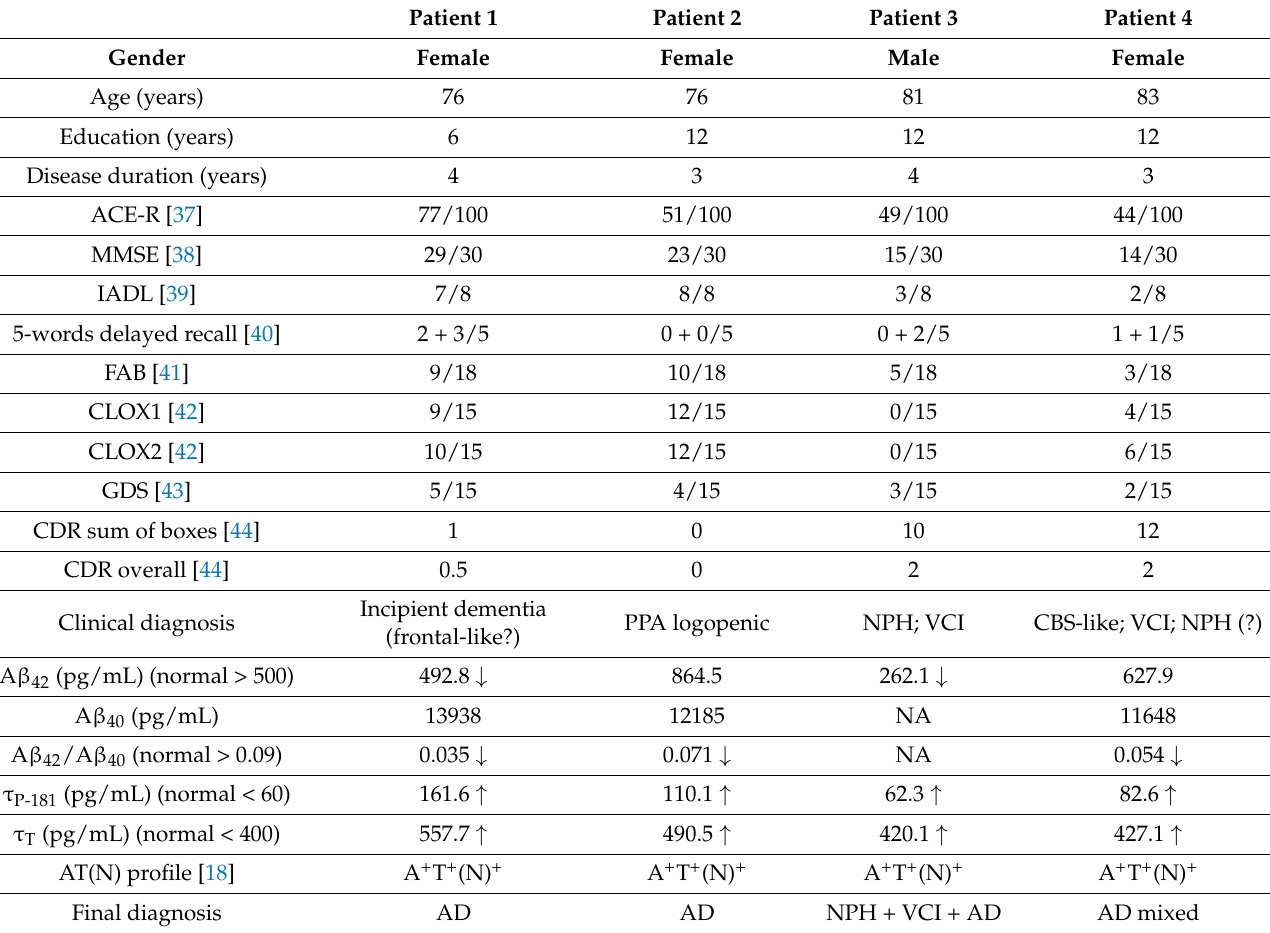
Table 1. Demographic, clinical, and neurochemical data of the four